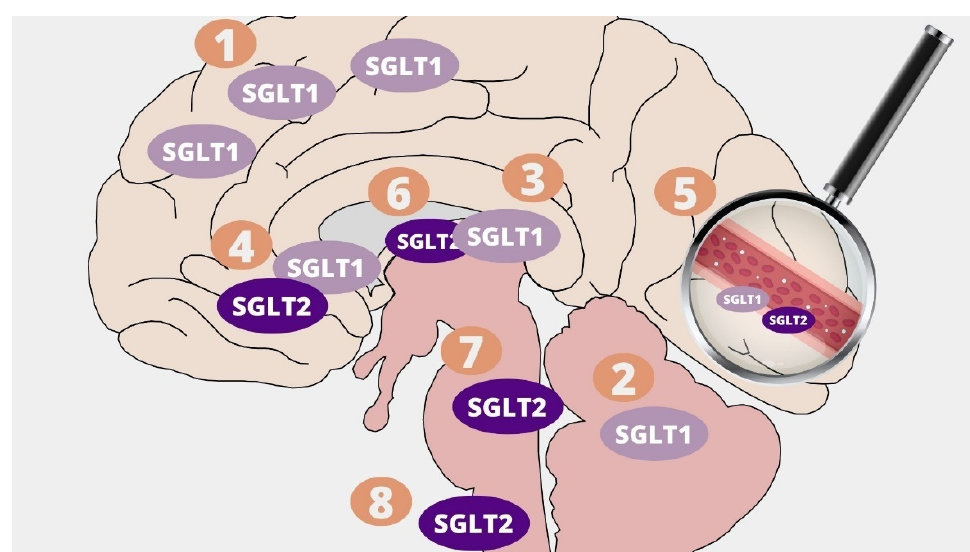
Figure 1. Distribution of SGLT1 and SGLT2 receptors in the Central Nervous System: 1. Pyramidal cells of brain cortex; 2. Purkinje cerebellum cells; 3. Hippocampus pyramidal and granular cells; 4. Hypothalamus; 5. Microvessels; 6. Amygdala; 7. Periaqueductal grey; 8. Dorsomedial medulla—nucleus of the solitary tract (NTS).